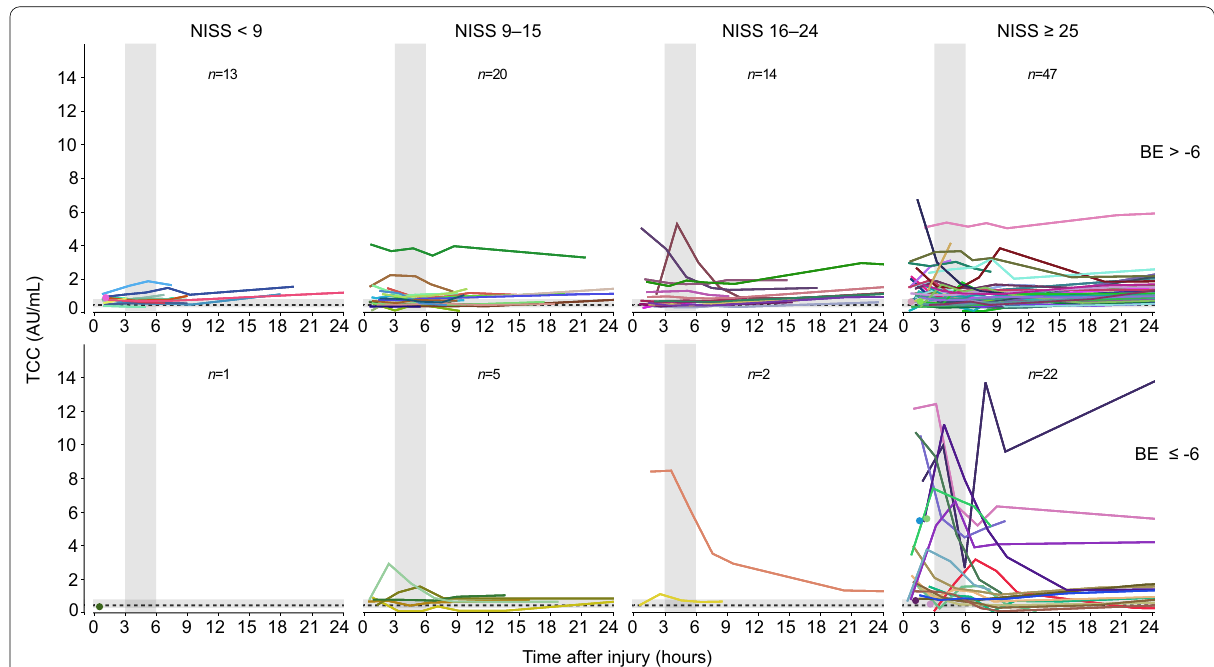
Fig. 1 Complement activation during the first 24 hours after trauma. Individual Terminal Complement Complex (TCC) concentration curves for the 124 trauma patients with documented admission base excess (BE), grouped by severity of anatomical injury (New Injury Severity Score, NISS) and physiological derangement (BE). Black dashed lines represent median TCC concentration and grey corresponding areas interquartile ranges for the reference population of 20 healthy volunteers. The grey shaded columns show the time interval used for computation of area under the TCC concentration curve 3–6 hours after injury (TCC-AUC 3–6